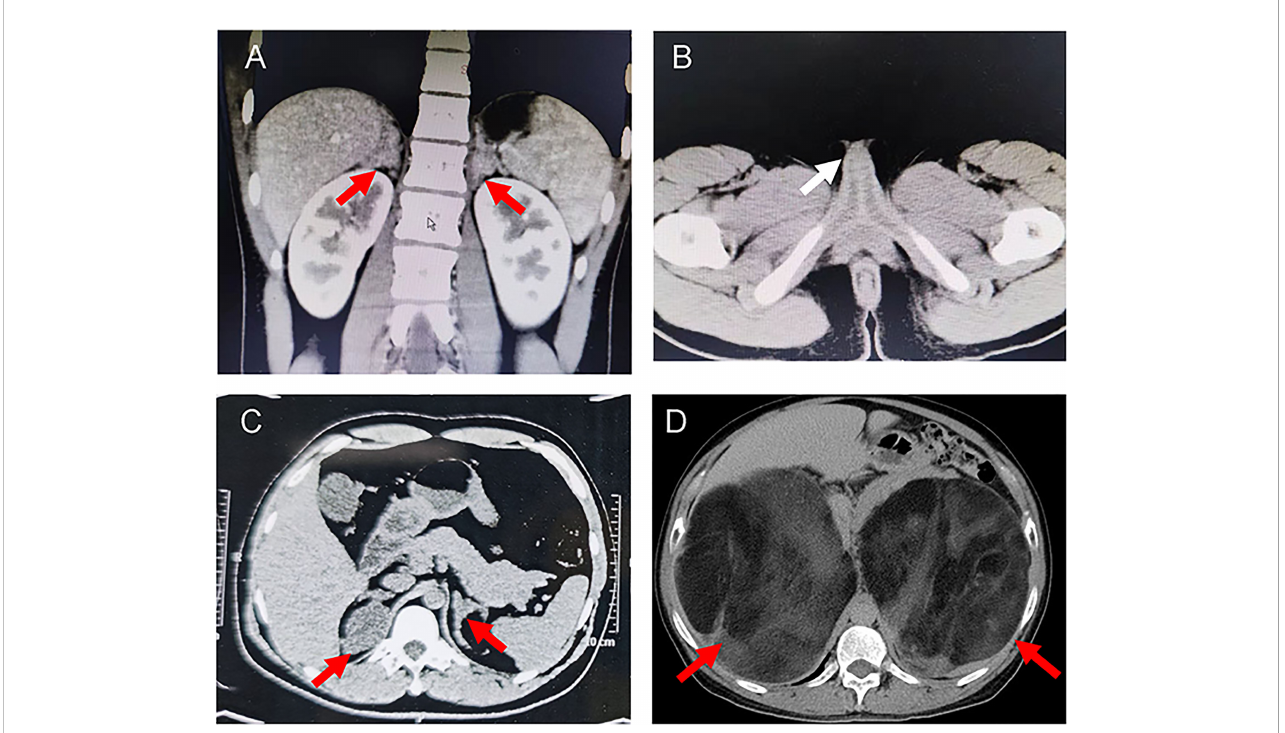
FIGURE 2 Representative computed tomography (CT) scans of the probands. (A) CT images showing bilateral adrenal hyperplasia in the proband 1. (B) Pelvic CT image of proband 1 indicated the cavernous structure in the perineum (white arrow). (C) CT images showing left adrenal hyperplasia and right adrenal adenomatous hyperplasia (4.3*3.7 cm) in the proband 2. (D) CT image showing giant bilateral adrenal masses (left: 20*25 cm; right: 30*40 cm) in the proband 3. The red arrows indicate the adrenal